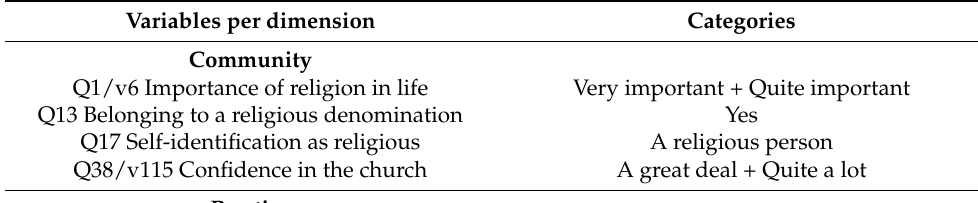
Table 1. Selected variables and respective